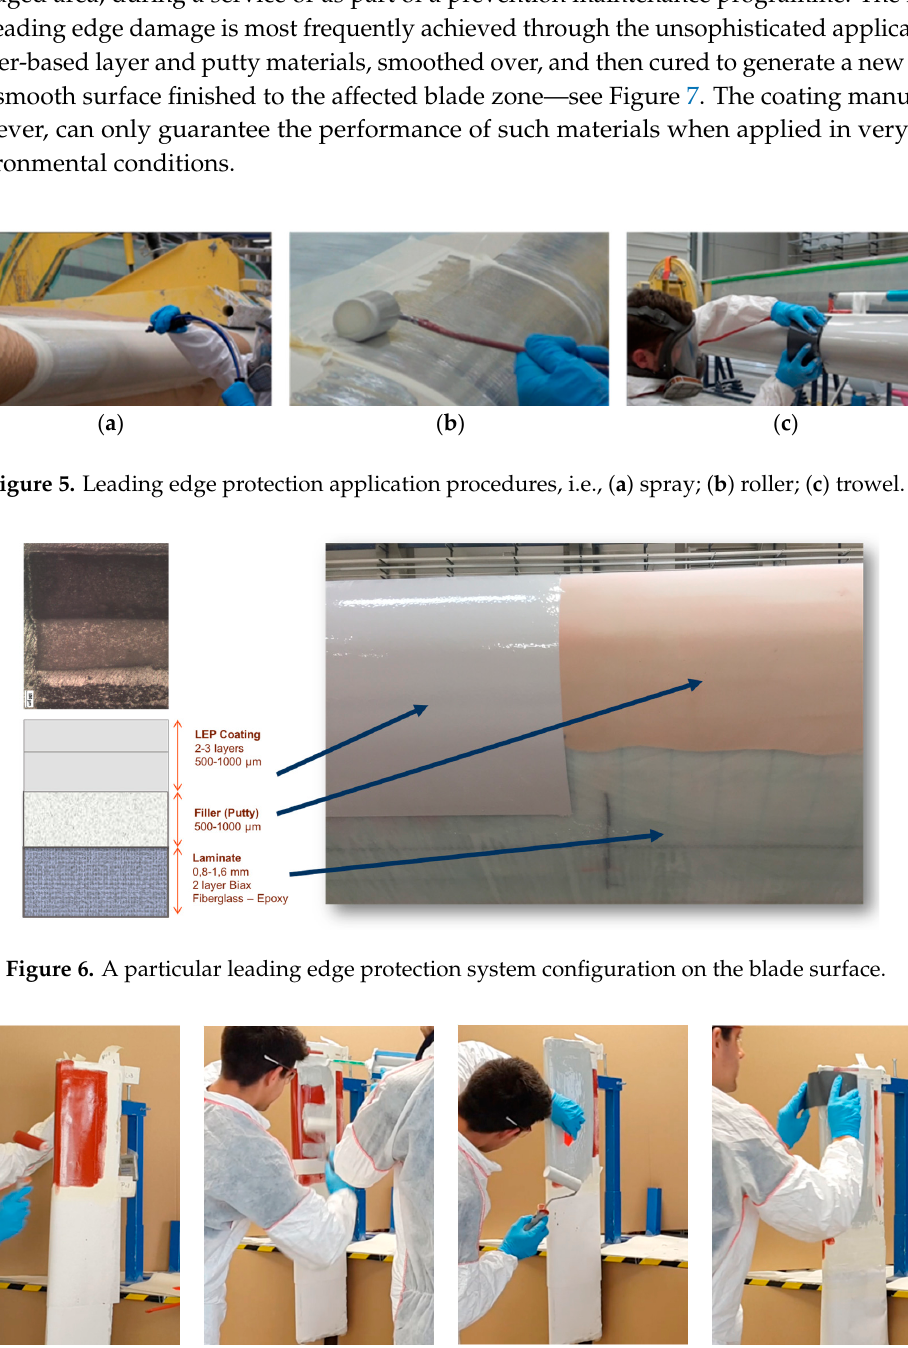
Figure 7. Leading edge protection service application with different techniques: ( a ) application of the primer layer; ( b ) application of the putty/filler/LEP material; ( c ) the thickness of the coating needs to be monitored closely; ( d ) the surface of the material is screeded down to ensure a flat, smooth surface following the blade contour.